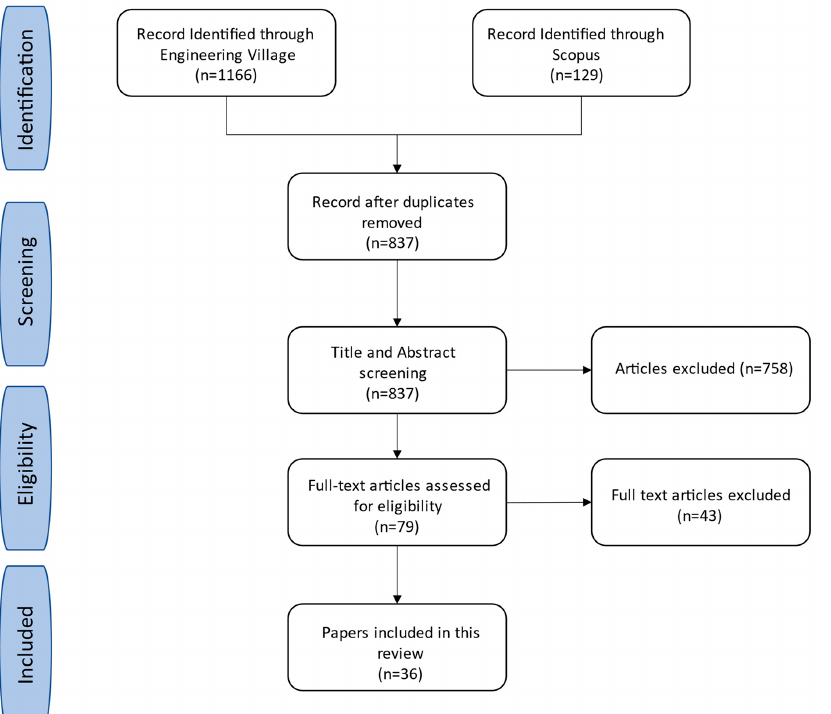
Figure 1. Search Strategy Flow Chart.